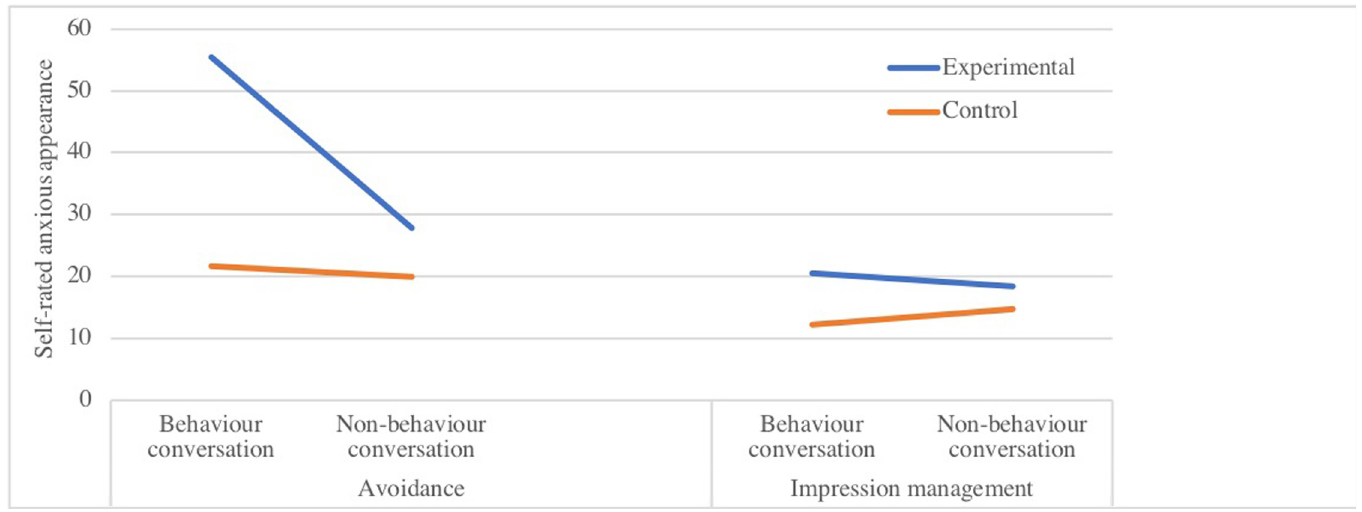
Fig 3. Three-way interaction of safety behaviour type, conversation type and participant type on self-ratings of how anxious one looked.